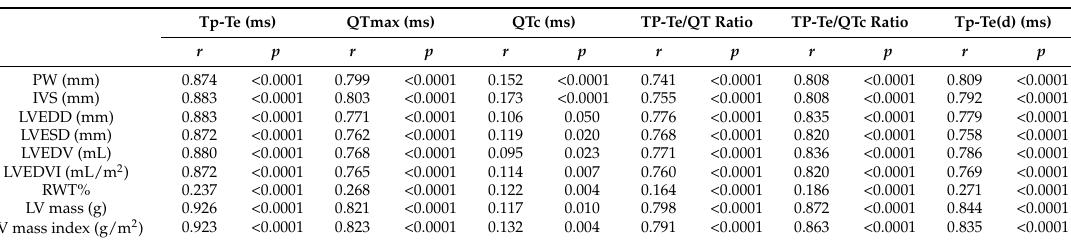
Table 2. Pearson correlation analysis between ventricular repolarisation parameters and echocardiographic parameters.